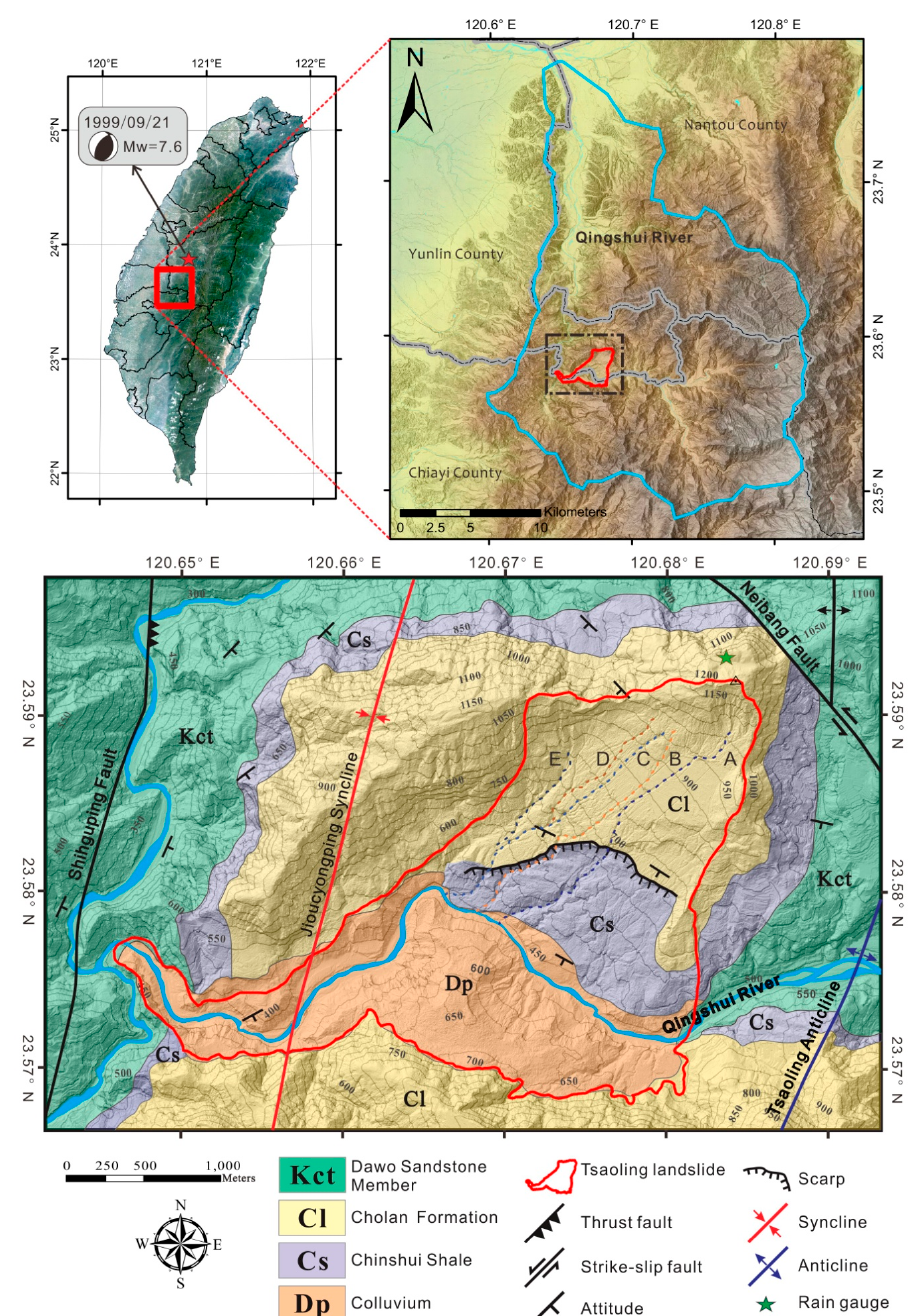
Figure 1. The location of the study area and the geological map: ( top ) the location of the Qingshui River relative to the adjacent counties. The red star in the upper left figure is the epicenter of the Mw 7.6 Chi-Chi earthquake in 1999 [2]; ( bottom ) the geological map of the Tsaoling area with the main Tsaoling landslide area circumscribed by the red line. The dashed lines of different colors indicate the five gullies (A–E) on the landslide slope. The green star is the location of the CWB rain gauge station.